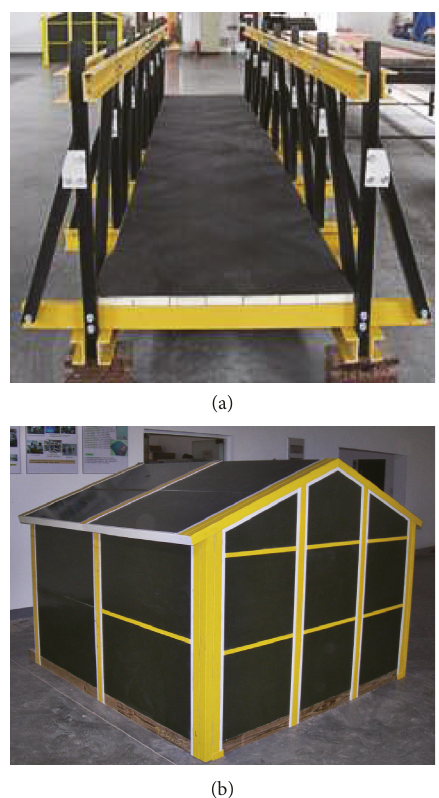
Figure 1: Practical constructions using two-way lattice-web reinforced foam core composite sandwich panels as the main loading-bearing components: (a) a footbridge using sandwich panels as bridge decks and (b) a temporary house using sandwich panels as roof panels and wall